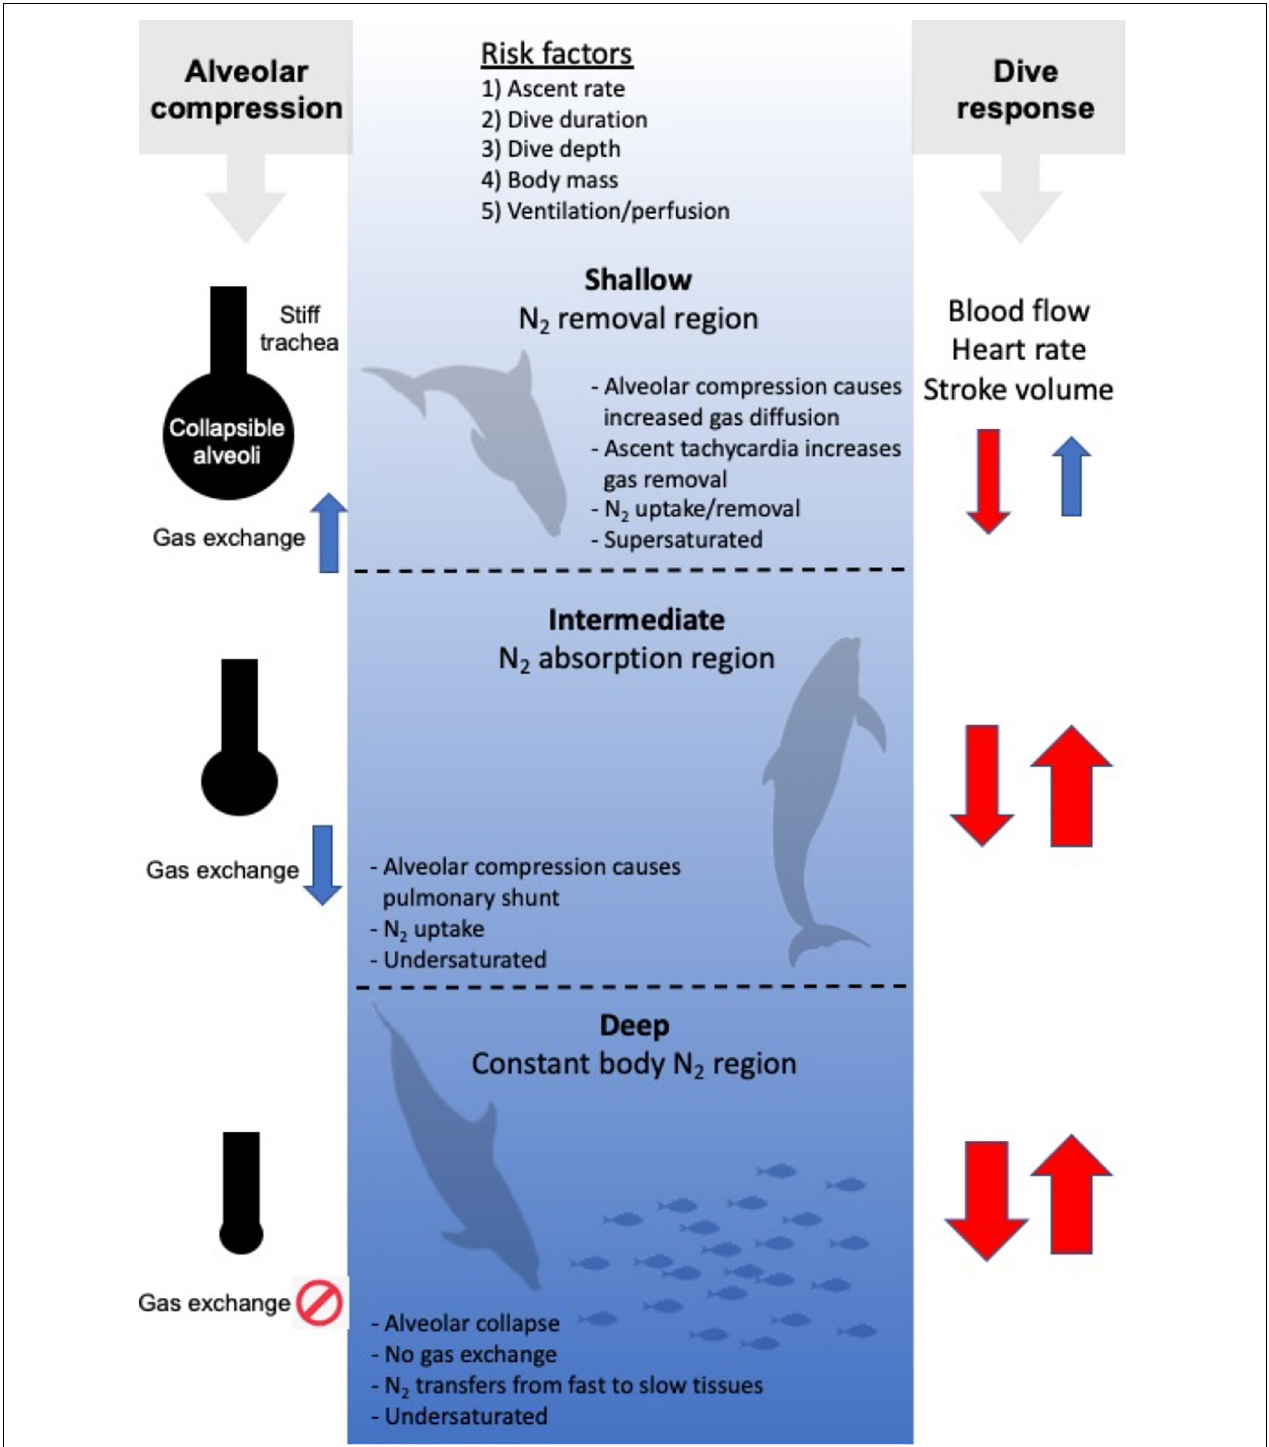
FIGURE 2 | Risk factors for gas bubble formation and Gas Emboli Pathology (GEP), and 3 hypothetical regions [Shallow (0–˜30 m), Intermediate (˜30–˜200 m), and Deep (beyond ˜200 m)]. In the Shallow region, tissue and blood PN 2 begins to exceed ambient PN 2 , and N 2 is removed. In the intermediate region, ambient PN 2 exceeds tissue and blood PN 2 and N 2 is taken up until the alveoli collapse in the Deep region. Following collapse, N 2 is being redistributed from fast tissues to slow tissues. On the left hand side, the balloon/pipe model proposed by Scholander (1940) is shown for how increasing dive depth causes alveolar compression and collapse. This initially causes an increase in the gas diffusion rate in the shallow region as the lung partial pressure increases. In the intermediate region the